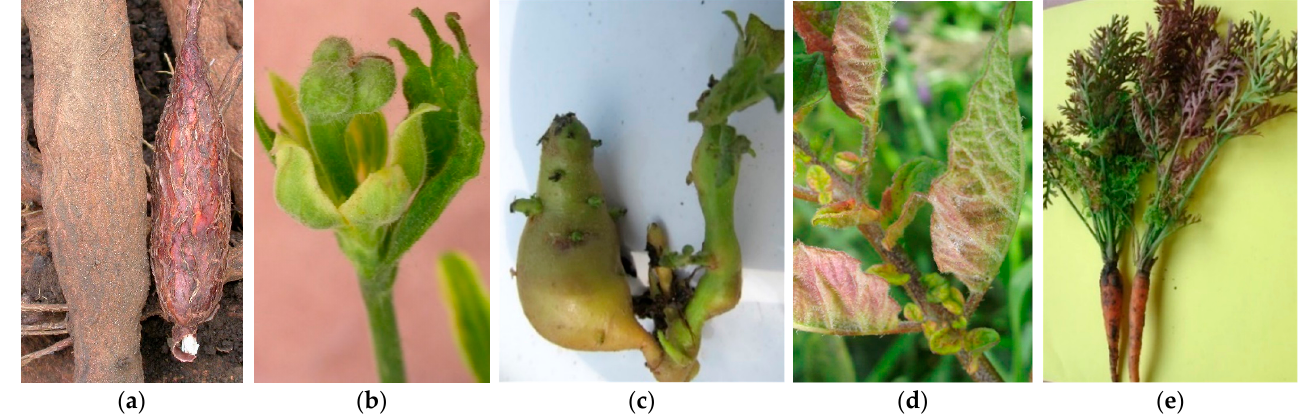
Figure 9. Cassava frog skin ( a ), tomato ( b ) and potato “stolbur” ( c ), potato purple top ( d ), and carrot reddening ( e ). Table 6. Molecular diversity and geographic distribution of selected phytoplasmas belonging to different ribosomal groups/‘ Candidatus Phytoplasma’ species (marked by different color) associated with purple top and other malformations.